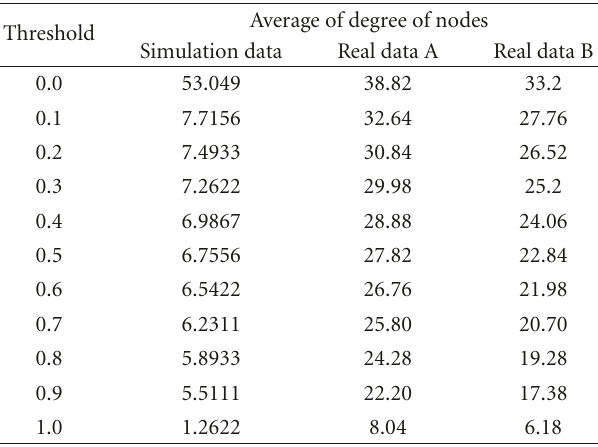
Table 3: Average of degree of nodes and threshold.